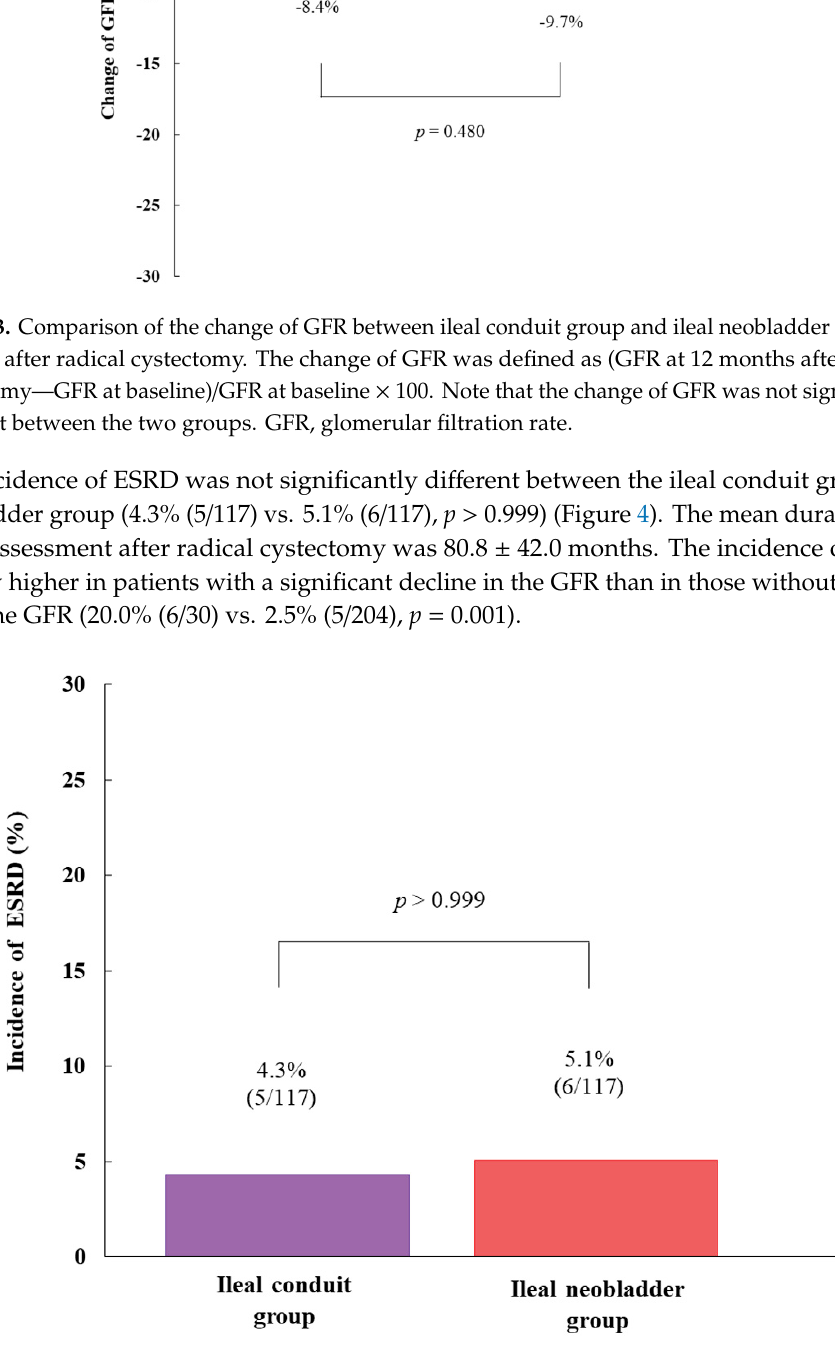
Figure 4. Comparison of the incidence of ESRD between ileal conduit group and ileal neobladder group 12 months after radical cystectomy. Note that the incidence of ESRD was not significantly di ff erent between the two groups. ESRD, end-stage renal